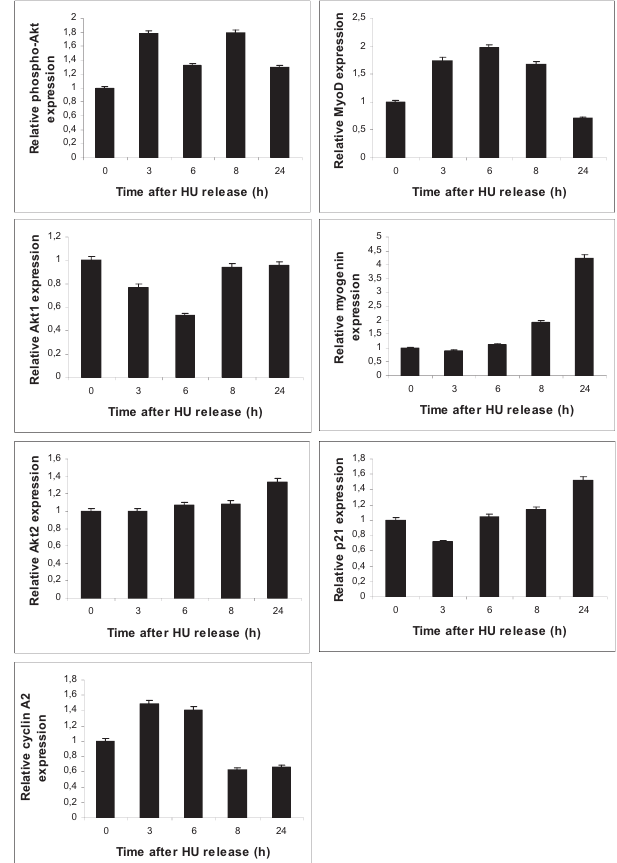
Figure 2. Myoblast double-block synchronization to the cell cycle exit point – Part 1. A. Total proteins were extracted from synchronized myoblasts 3, 6, 8 and 24 hours after the HU-block release. 20 m g of total proteins were loaded onto SDS-PAGE gels and blotted for phospho-Akt (P- Akt), Akt1, Akt2, cyclin A2, MyoD, myogenin, p21cip1 and GAPDH as a loading control. B. Quantification of phospho-Akt, Akt1, Akt2, cyclin A2, MyoD, myogenin and p21cip1 blots as a relative expression as compared to GAPDH protein expression (using Image J software). This experiment has been reproduced 4 times and Y error bars are shown on the graphs. Amylose affinity chromatography resin and eluted with Maltose (10 mm) under native conditions and according to the manufac- turer instructions.